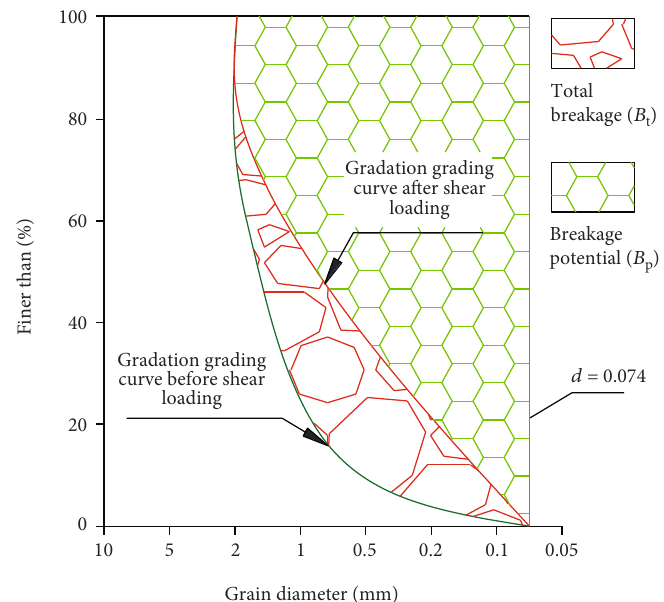
Figure 6: De fi nition of relative crushing ( B